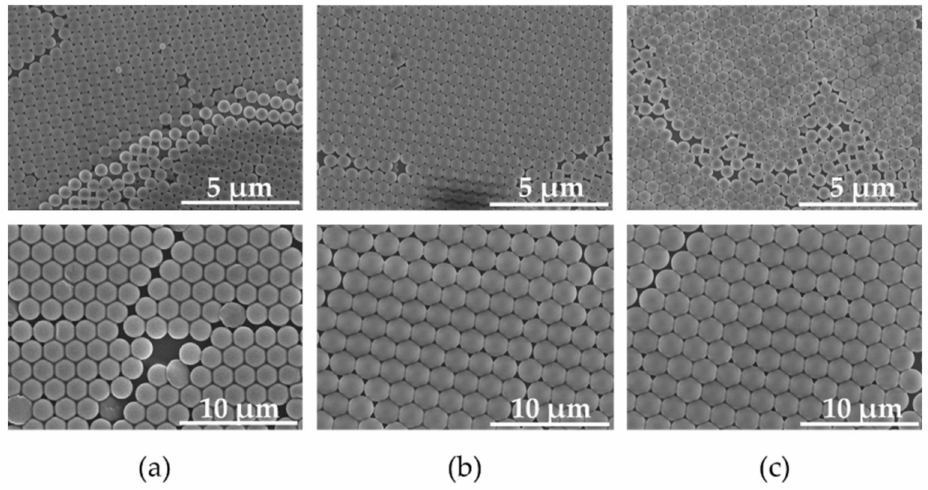
Figure 7. FE-SEM images of the self-assembled PS films prepared on a substrate with the deposition angle of 45 ◦ and the different deposition speeds: ( a ) 1, ( b ) 5, and ( c ) 9 µ m/s.